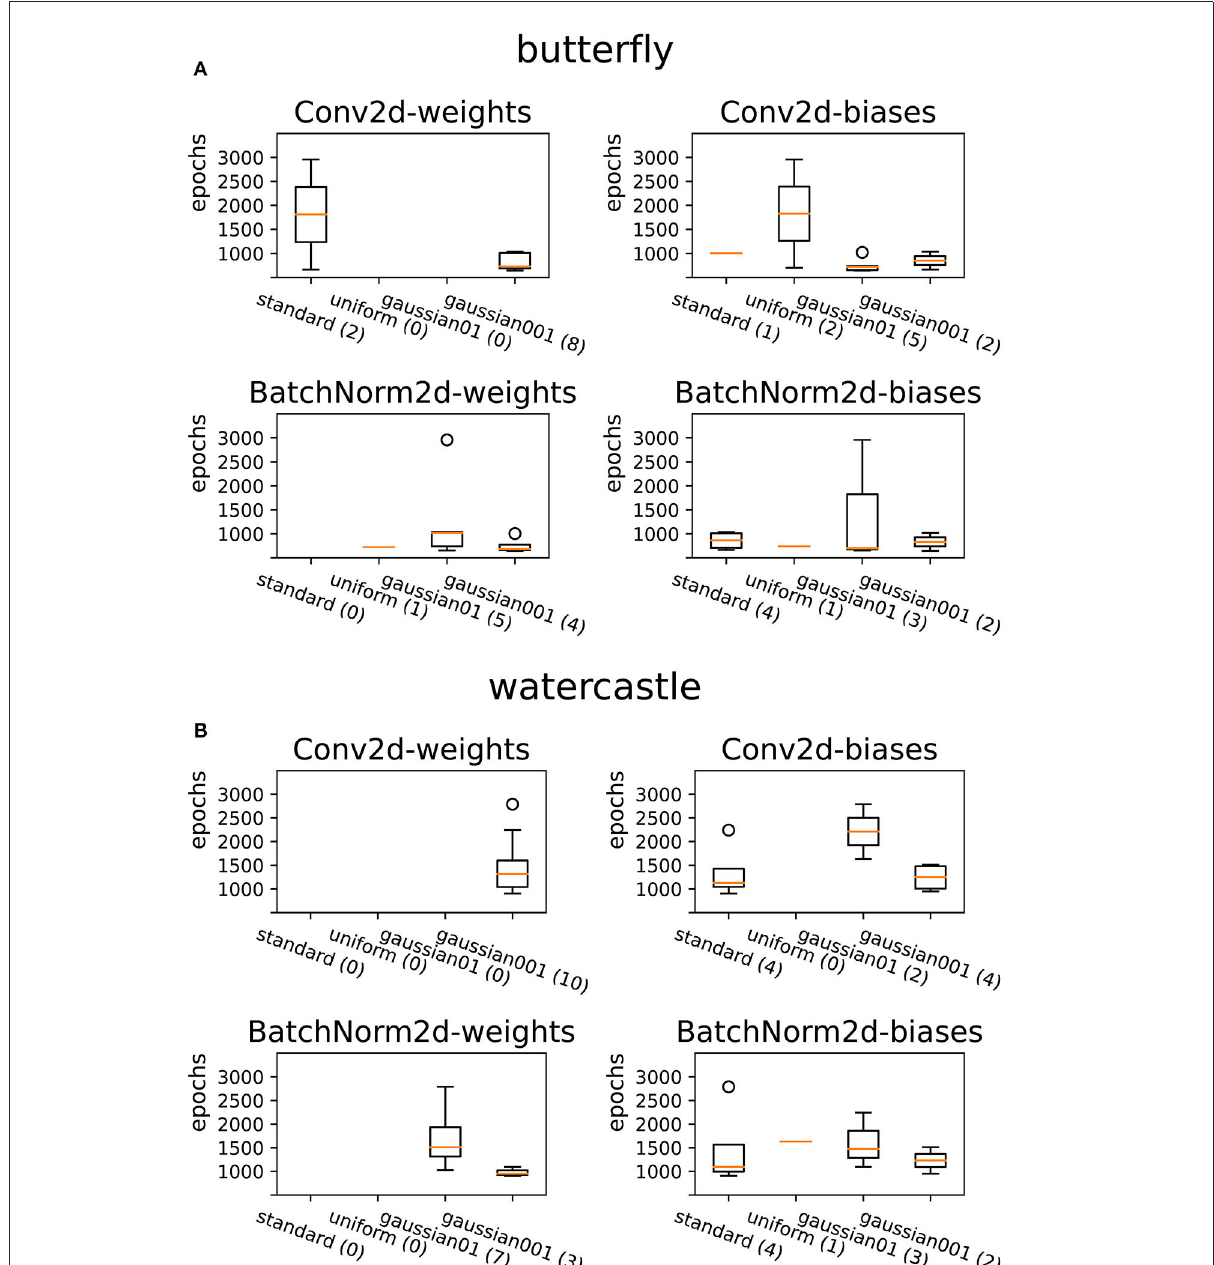
FIGURE7 Initialization with respect to the convergence speed of the first top- K experiments (with K set to 10) with higher PSNR values for the butterfly image (A) and watercastle image (B) .